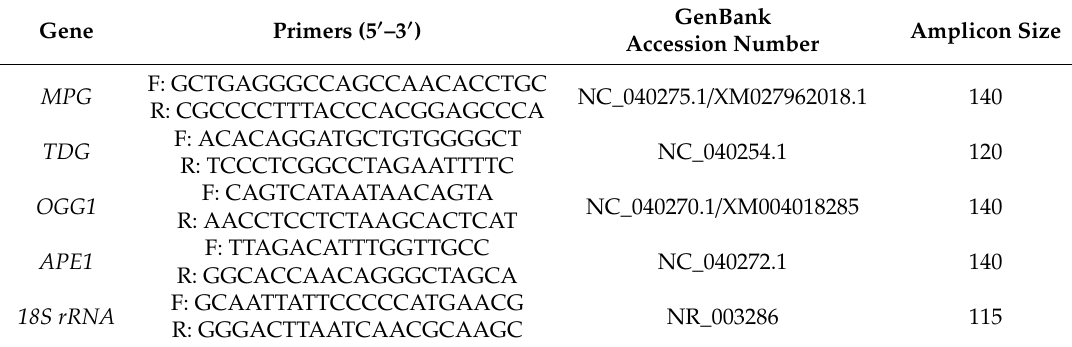
Table 1. Sequences of specific